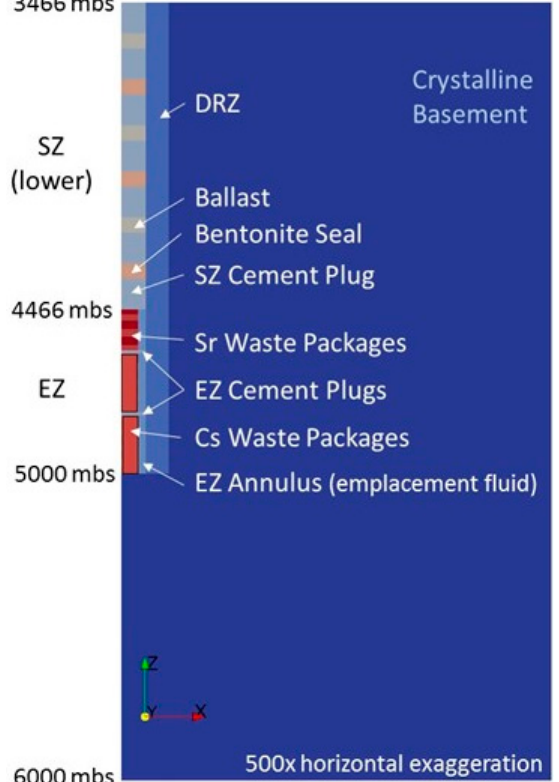
Figure 5. A portion of the DBD PA model domain for the nominal scenario. Source: Freeze et al. [5].